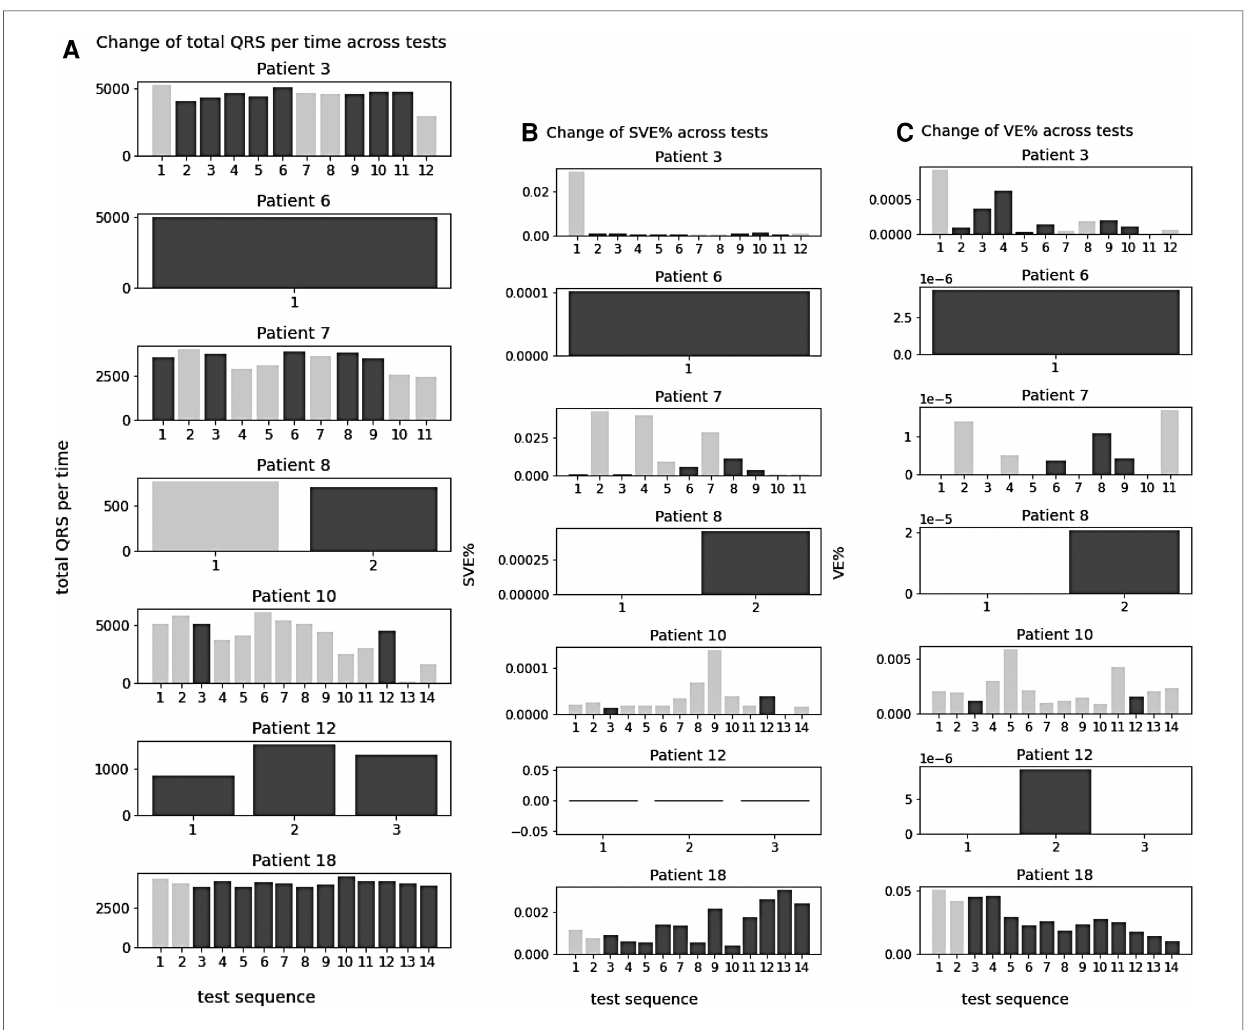
FIGURE 5 Change of QRS complexes, SVE%, and VE% across tests within arrhythmia patients. ( A – C ) Tests with arrythmia detected are shown in